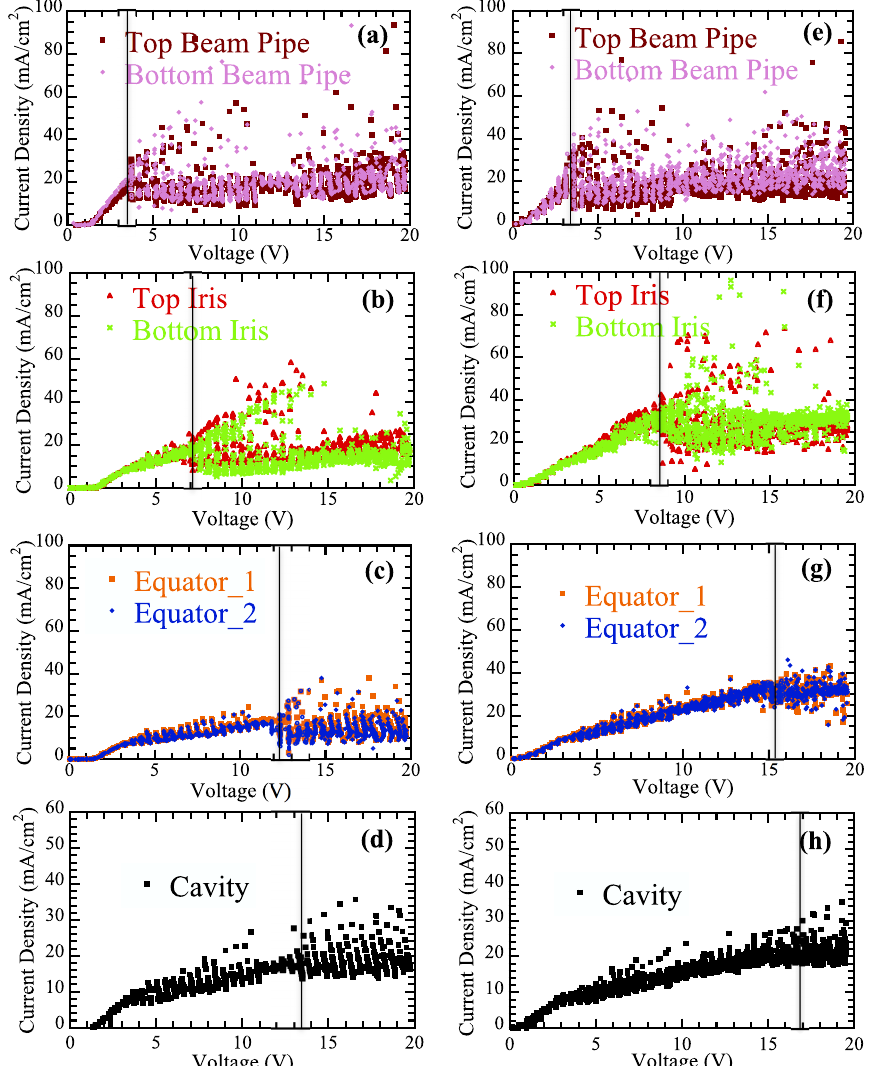
FIG. 16. Polarization curves obtained for the beam pipe, iris, and equator coupons, and cavity with NC-2 at 0 rpm (a) – (d) and 50 rpm (e) – (h). Solid vertical lines represent a transition from the etching region to the oscillation region followed by the polishing